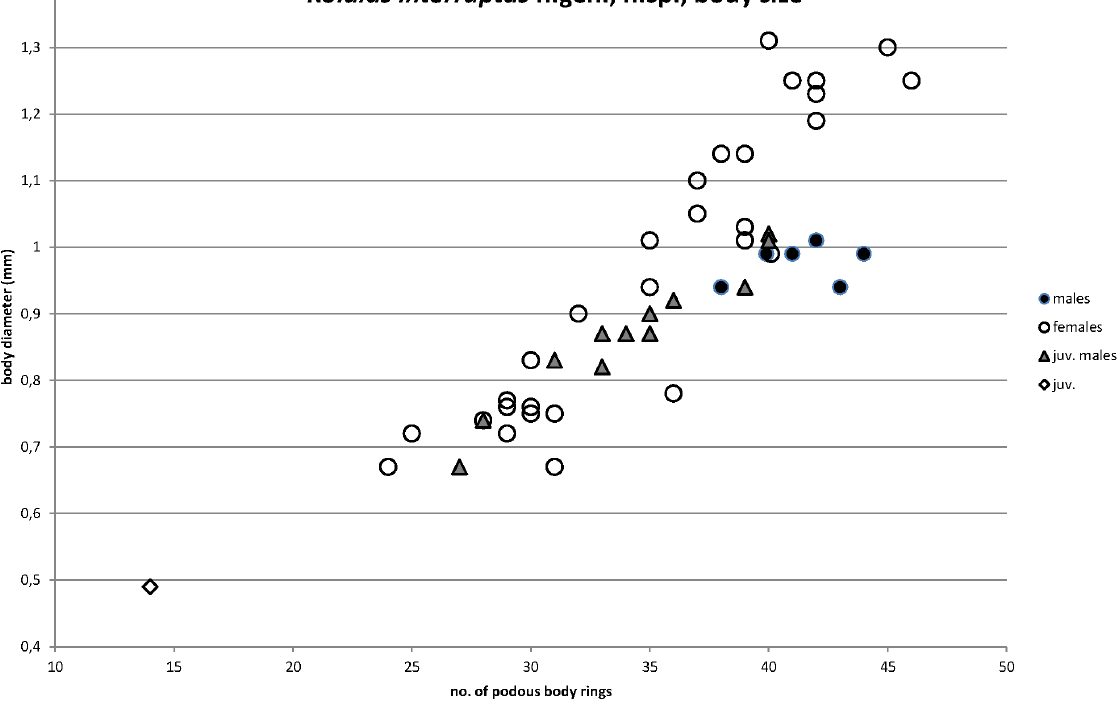
Fig. 2. Koiulus interruptus gen. et sp. nov. Body size as expressed by number of podous body rings and midbody